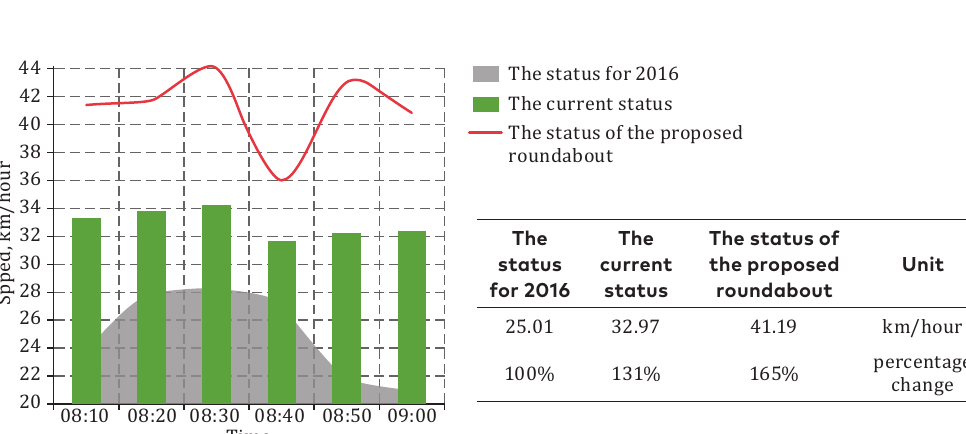
Figure 19. Speed-time